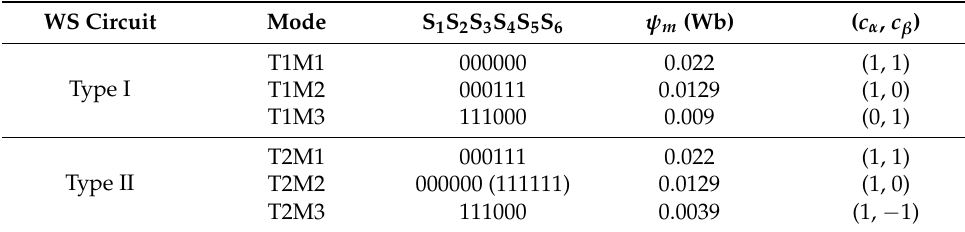
Table 2. Characteristics of each mode using WS